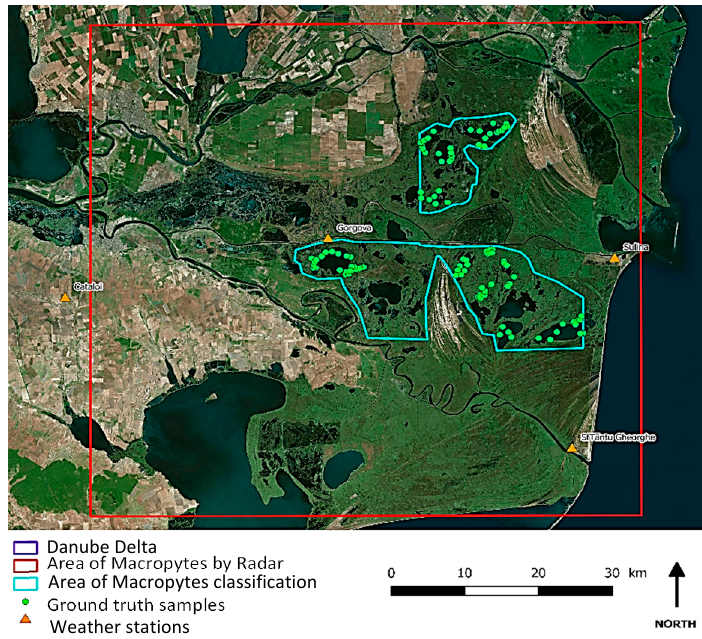
Danube Delta Area of Macropytes by Radar Area of Macropytes classification Ground truth samples Weather stations Figure 2. Location of the study site, ground reference samples, and weather